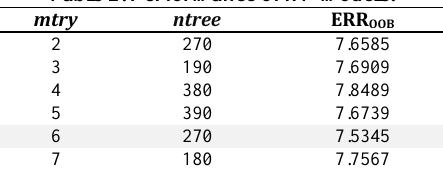
Table 2. Performance of RF